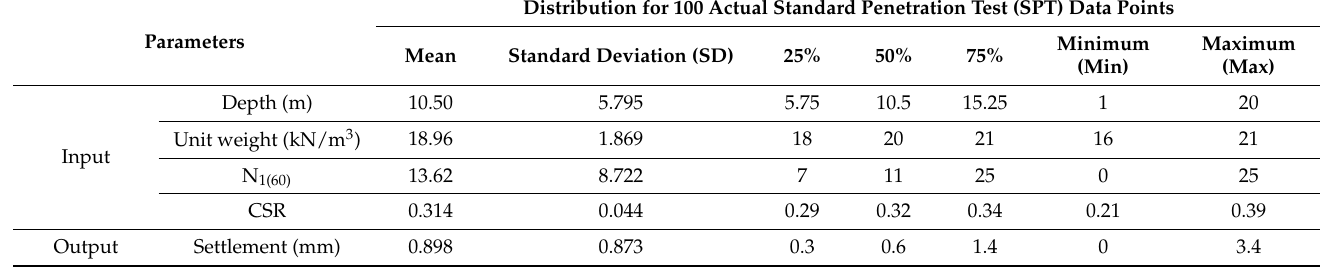
Table 1. Summary statistics of the actual dataset used in this study.